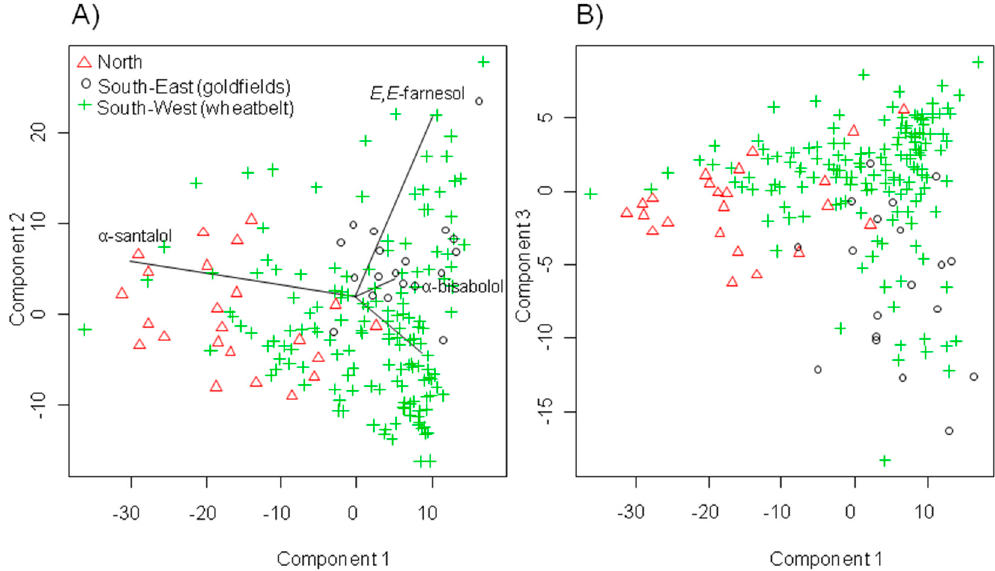
Figure 4. Two dimensional principal component analysis (PCA) ordination scores of S. spicatum sesquiterpene samples from the heartwood of 194 trees. Each point represents an individual tree, and points close together are similar in terms of composition. The first three components represent 95% of the total variance: ( A ) represents components 1 and 2 and ( B ) represents components 1 and 3 . Lines indicate ordination scores of the variables used.